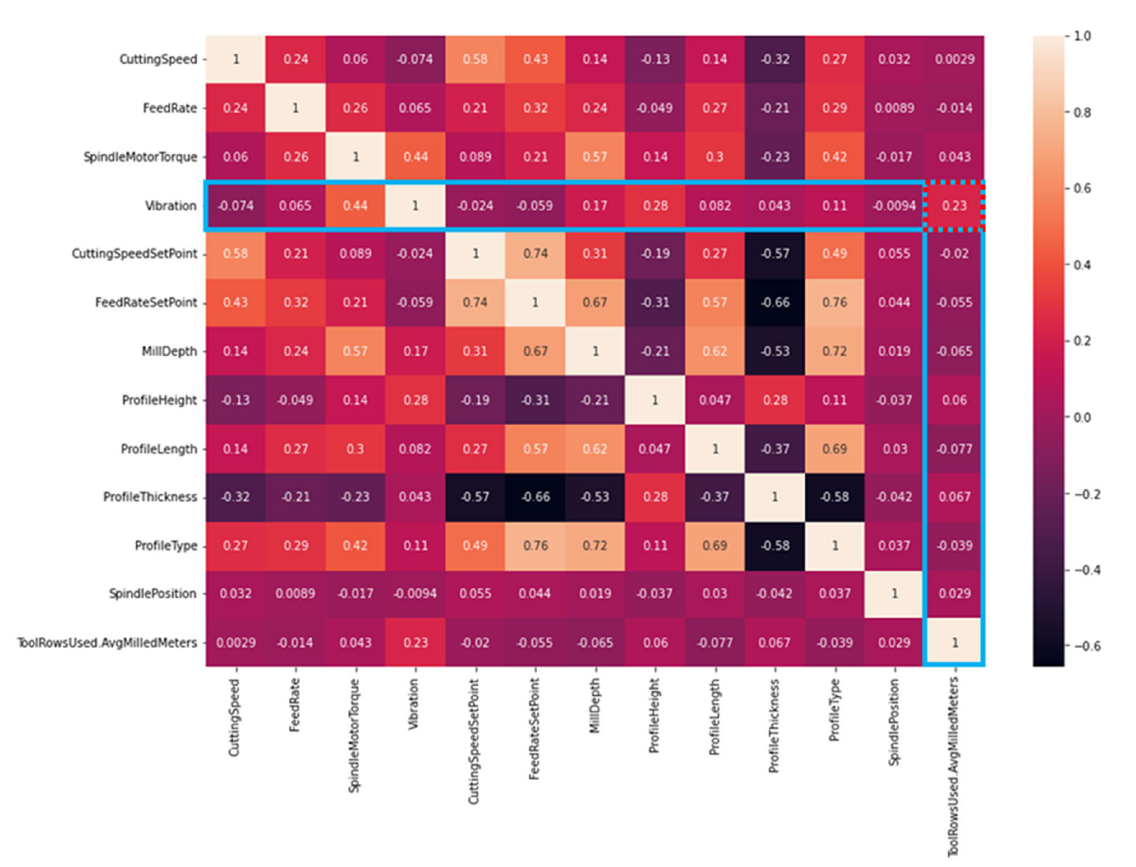
Figure 3. Pearson correlation heatmap illustrating the numeric and visual correlation between the scaled-down parameters.